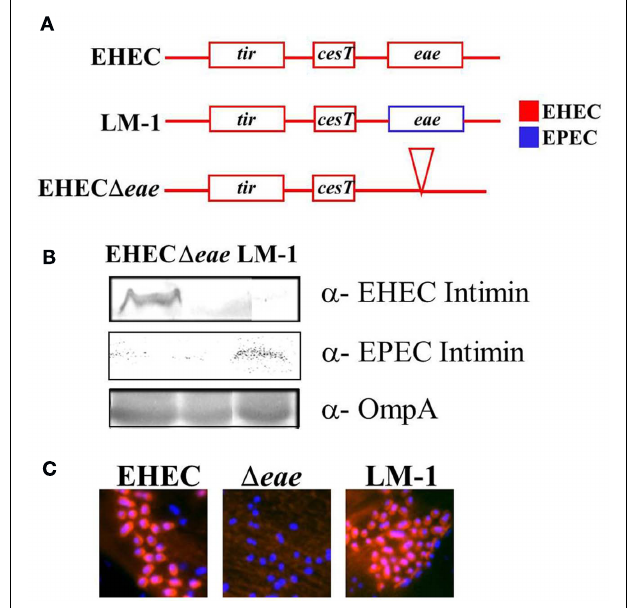
FIGURE 1 |An EHEC strain containing EPEC intimin on the chromosome is functional for pedestal formation. (A) The endogenous EHEC eae gene was precisely replaced by EPEC eae to create LM-1. (B) Expression of EHEC and EPEC intimin in wild type EHEC, EHEC Δ eae , and LM-1 was assessed by western blot. Blotting with anti-OmpA was included as a loading control. (C) HeLa cells were infected with the indicated strain and the monolayers were stained with DAPI (blue) to visualize bound bacteria and phalloidin (red) to visualize actin